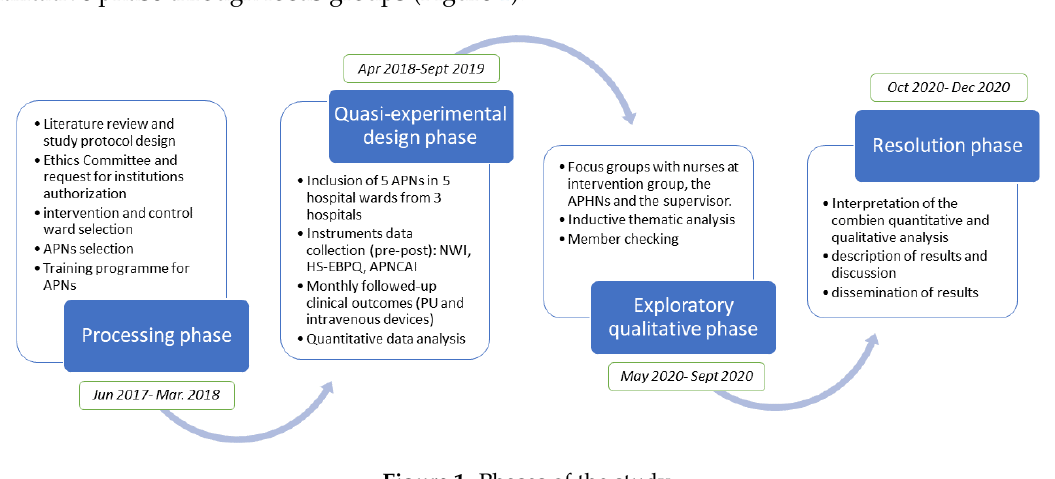
Figure 1. Phases of the study.